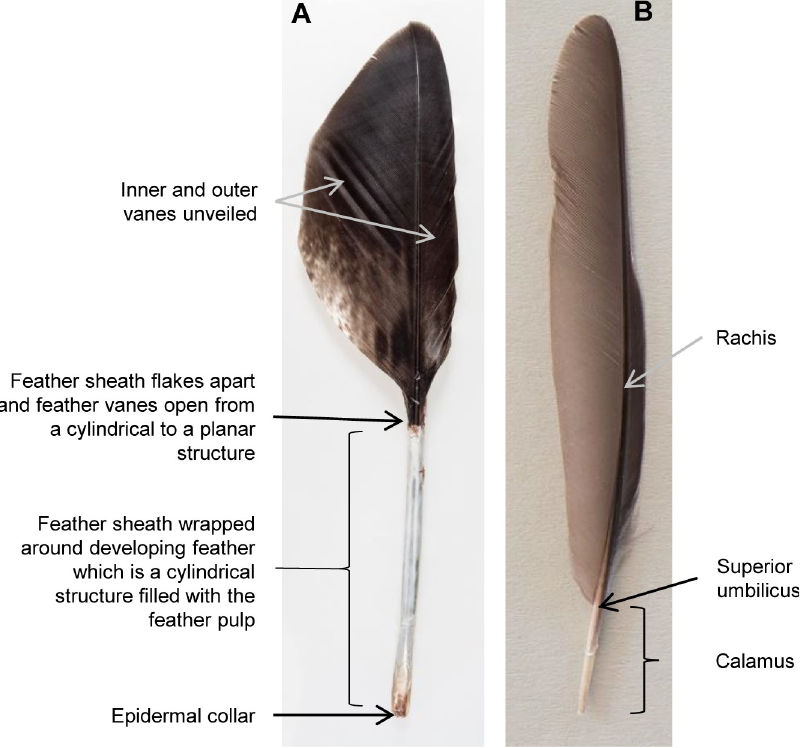
Fig 1. Morphology of a growing feather. (A) A growing feather (primary of a Golden Eagle Aquila chrysaetos ). Essentially all feather growth takes place within the ring structure of the epidermal collar of the follicle which is located at the base of the feather [4]. The epidermal collar produces cells which migrate up and proliferate the cells which produce the feather keratinocytes arranged in the form of a cylinder [15–18]. Nutrient supply for the differentiation, elongation and keratinization of the keratinocytes is via the feather pulp, which fills the cylinder of the developing feather. When the feather pulp retreats and the feather sheath brakes away the vanes unfold. (B) Full-grown feather (primary of a Common Blackbird Turdus merula ). When the production of barb ridges ends, the cylinder, which opens to unveil the feather vanes, turns into the calamus which maintains its cylindrical shape and therefore represents the diameter of the feather follicle during the last phase of growth (e.g. 4). Therefore, we measured the diameter of the calamus in the dorso-ventral and distal-proximal direction at the transition to the rachis (at the superior umbilicus, which is the widest point of calamus and rachis) as a proxy of epidermal collar